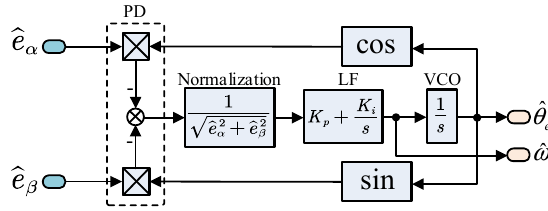
Figure 1. Block diagram of the conventional QPLL.